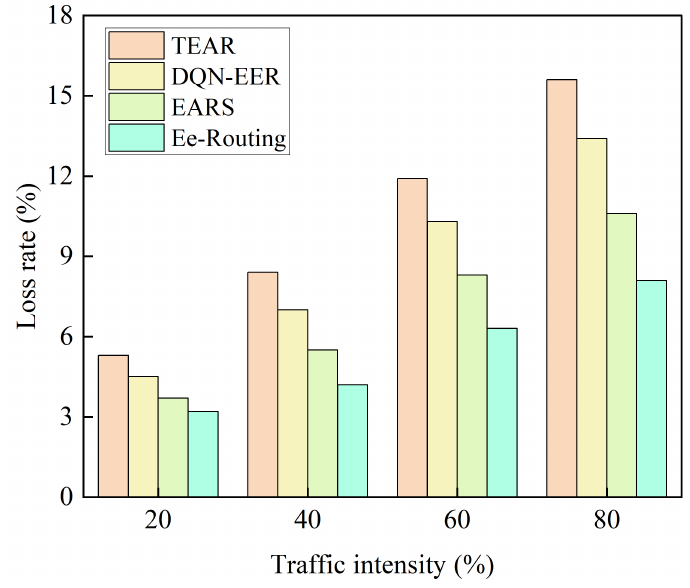
Figure 11. Packet loss rates comparison under different traffic